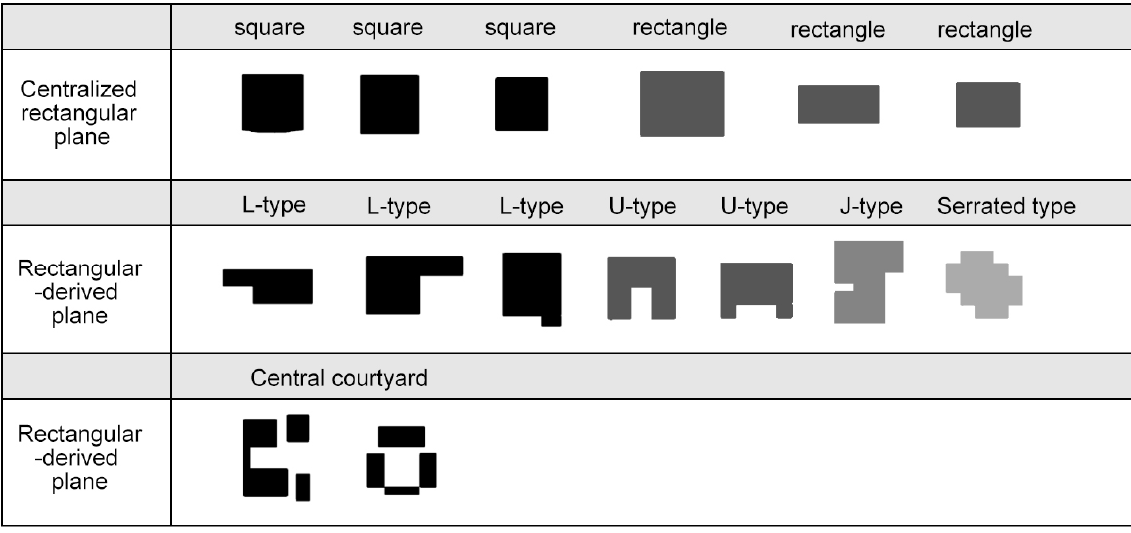
Figure 5. Building plane shape. 3.1.2. Building Functions The functional structure of the building is closely related to its design concept, which fundamentally determines the design layout of the building. Climate condition is an im- portant proposition in building an energy-saving design. Building design can be cut into the concept from the angle of social relations, human settlements, technology and so on, and then concretely expressed through building form and function. The salient features of the teams’ concepts can be divided into four categories: regionalism, modularization, human-habitat and publicness (see Table 3). The teams show different design preferences in concepts. Regionalism emphasizes responding to the natural environment of the build- ing; modularization emphasizes industrial systems; human-habitat emphasizes the com- fortable living; and publicness emphasizes the sharing in the regional level. Therefore, in